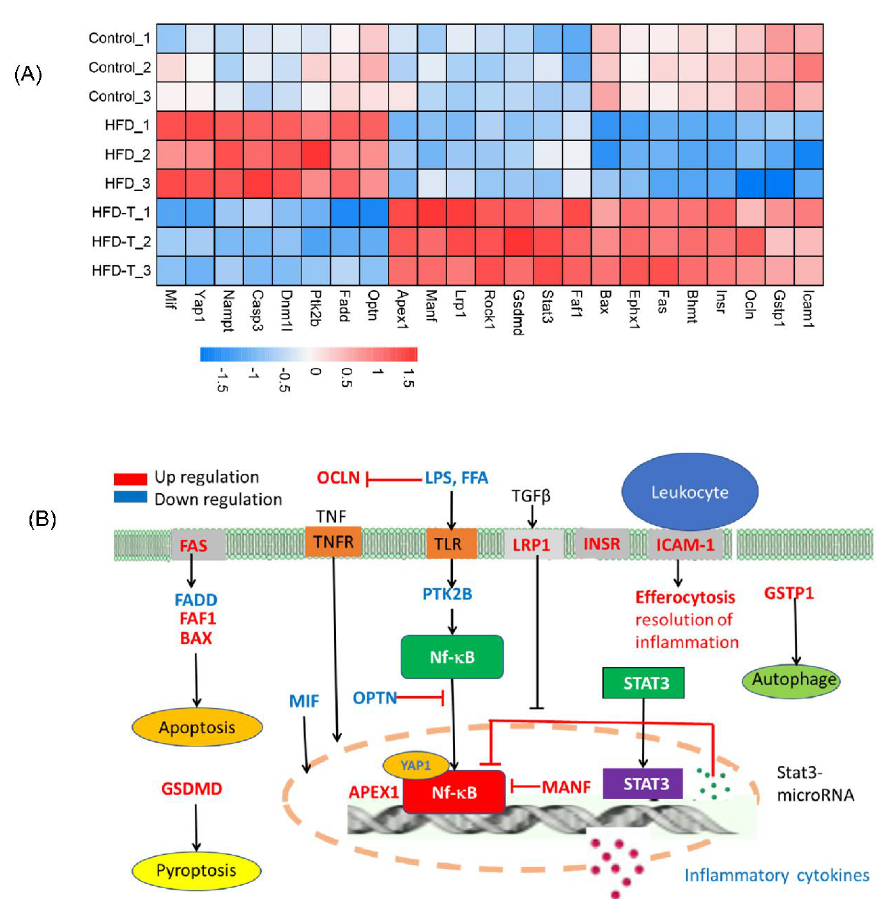
Figure 8. The anti-inflammation property of Torularhodin. The heatmap of inflammation-related proteins ( A ) and schematic illustration of the possible distribution of these proteins in the cells ( B ). Nf- κ B and STAT3 are transcription factors.